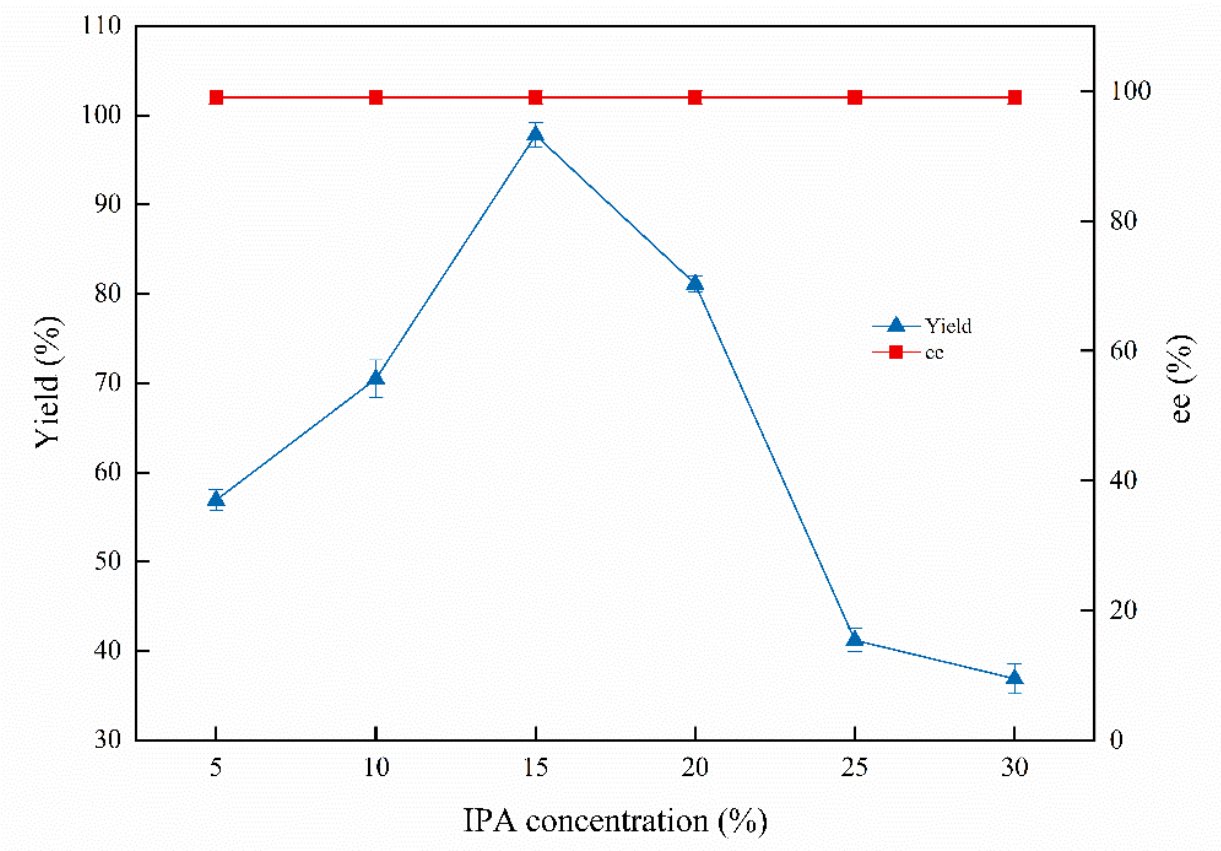
Figure 3. Effects of IPA concentrations on the biocatalytic reduction. Reaction conditions: 20.0 mL phosphate buffer (100 mM, pH 6.0), 1.0 g resting cells (DCW), 50 mM 1-chloro-2-heptanone, different concentrations of IPA, 200 rpm, 30 °C, 24 h. Table 1. Effect of pH on the bioreduction of